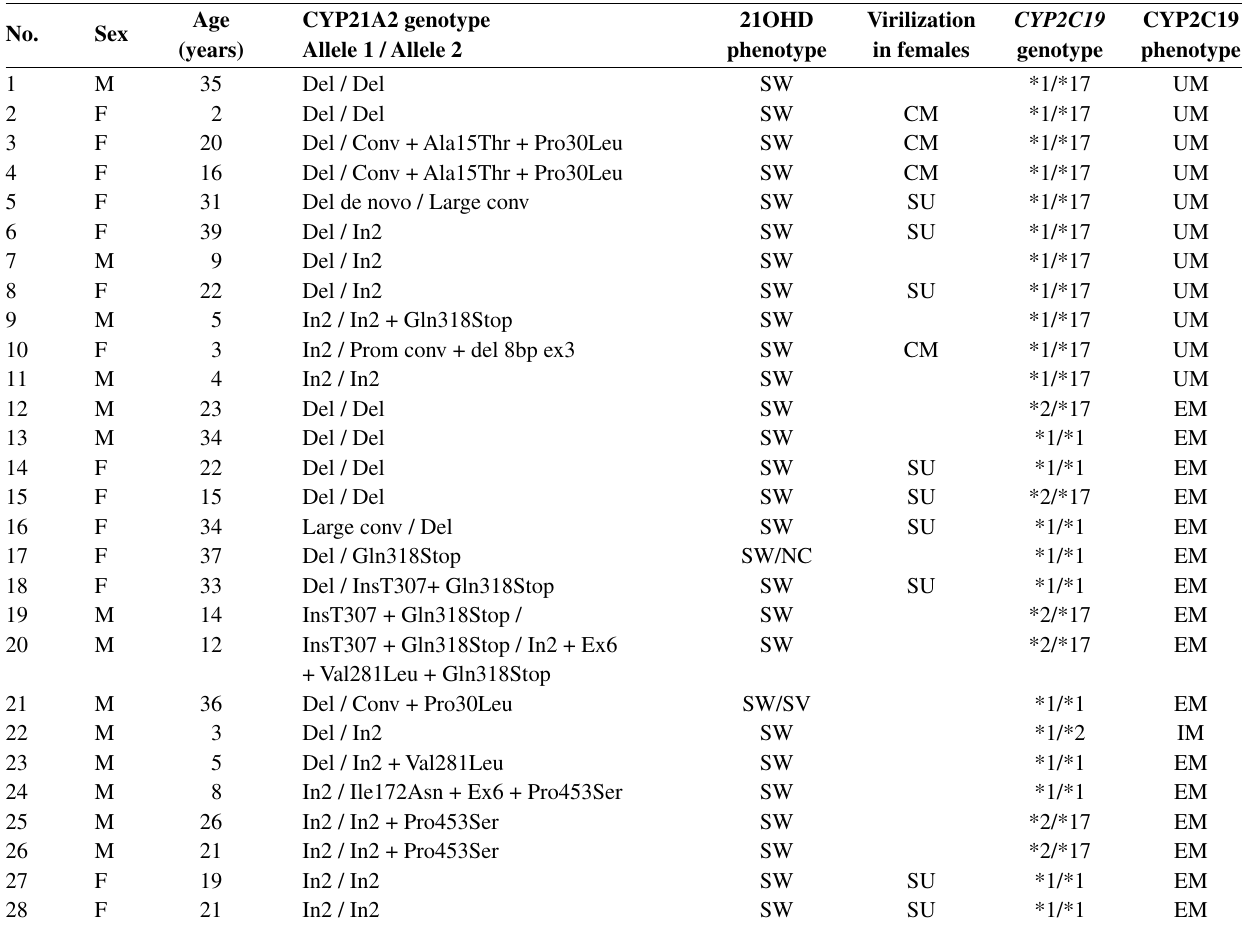
Table 1. Genetic and clinical characteristics of the patients Age CYP21A2 genotype 21OHD Virilization CYP2C19 CYP2C19 No. Sex (years) Allele 1 / Allele 2 phenotype in females genotype